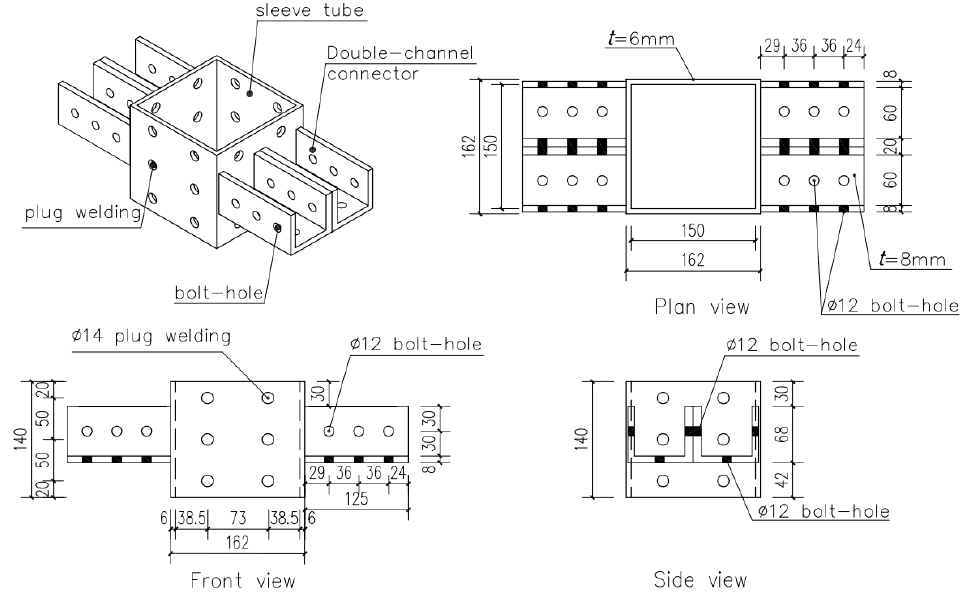
Figure 6. Double-channel connector welded with the SHS sleeve tube.